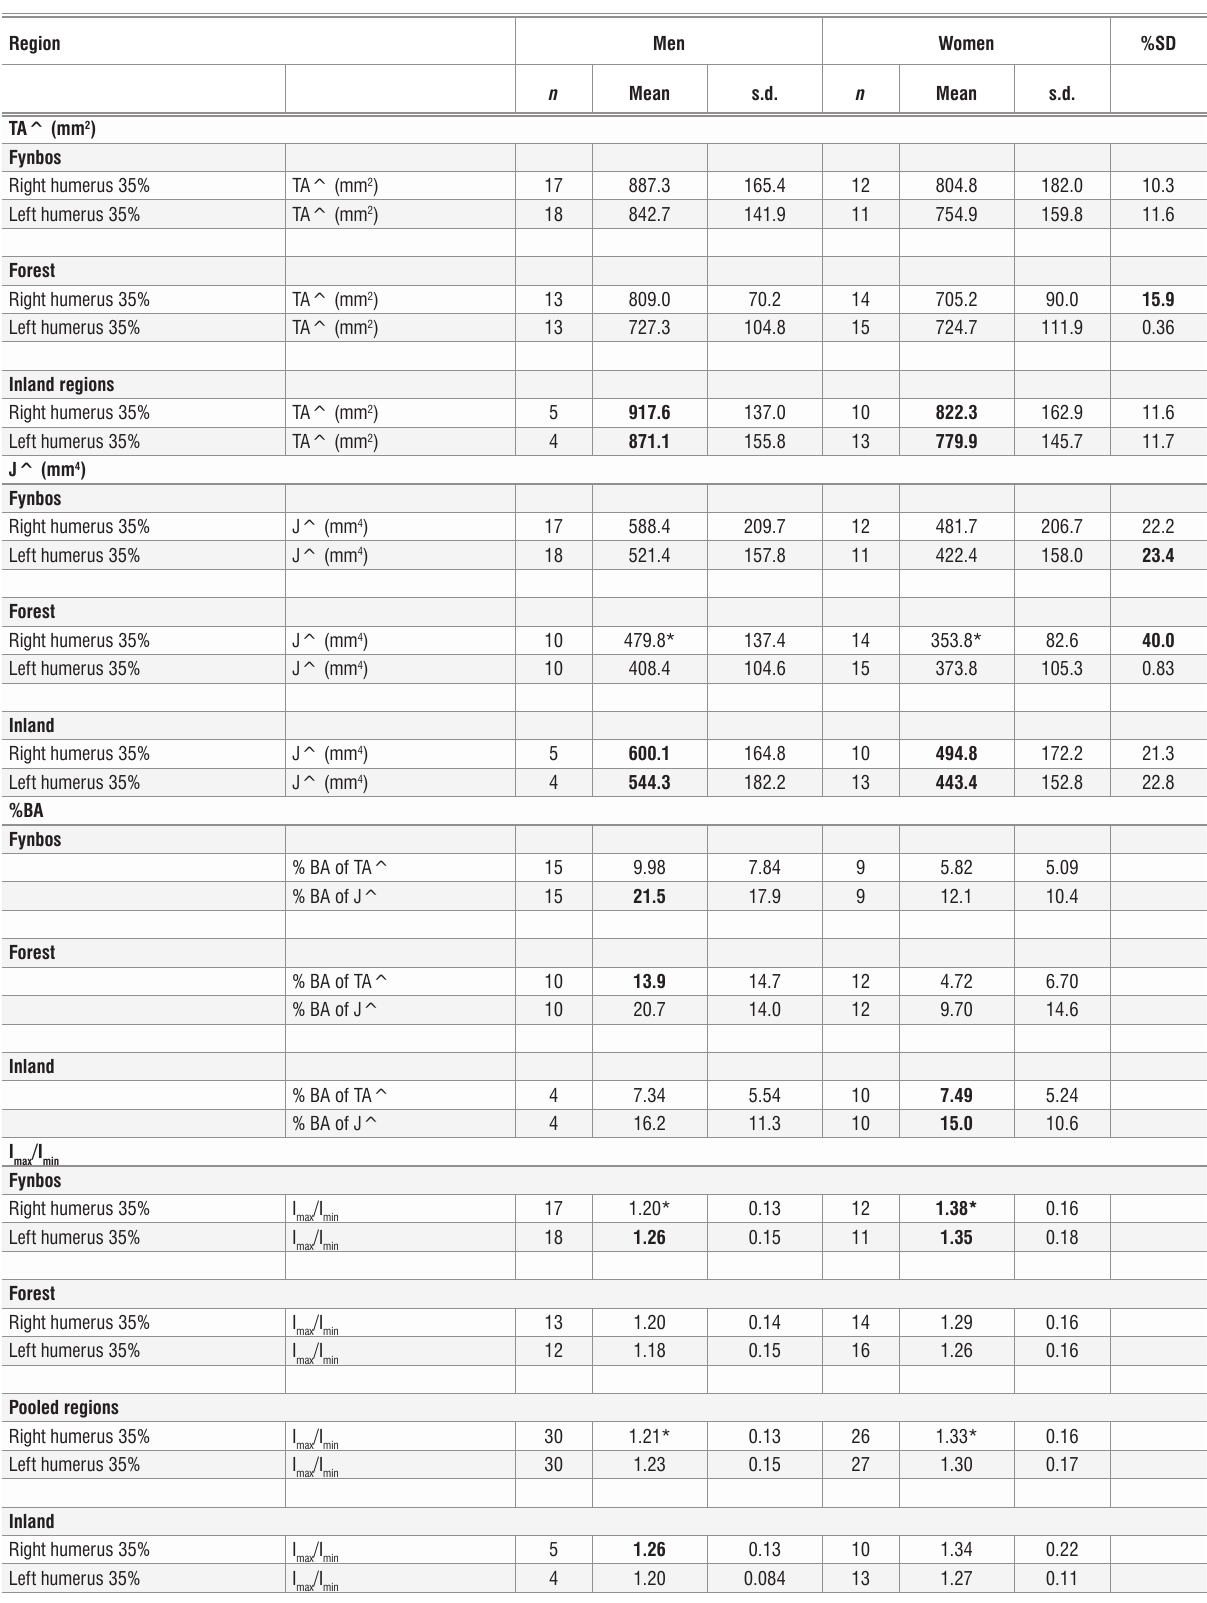
Table 3: Comparison of humerus total subperiosteal area (TA^), humerus torsional strength (J^), humerus bilateral asymmetry (%BA) in total subperiosteal area (TA^) and torsional strength (J^), humerus maximum versus minimum bending strengths (I dimorphism (%SD) for each property between the lower Orange River Valley (inland), fynbos and forest